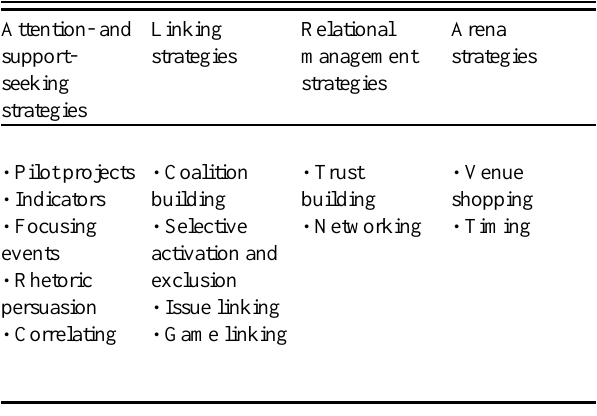
Table 2 . Strategies of policy entrepreneurs used in Dutch water